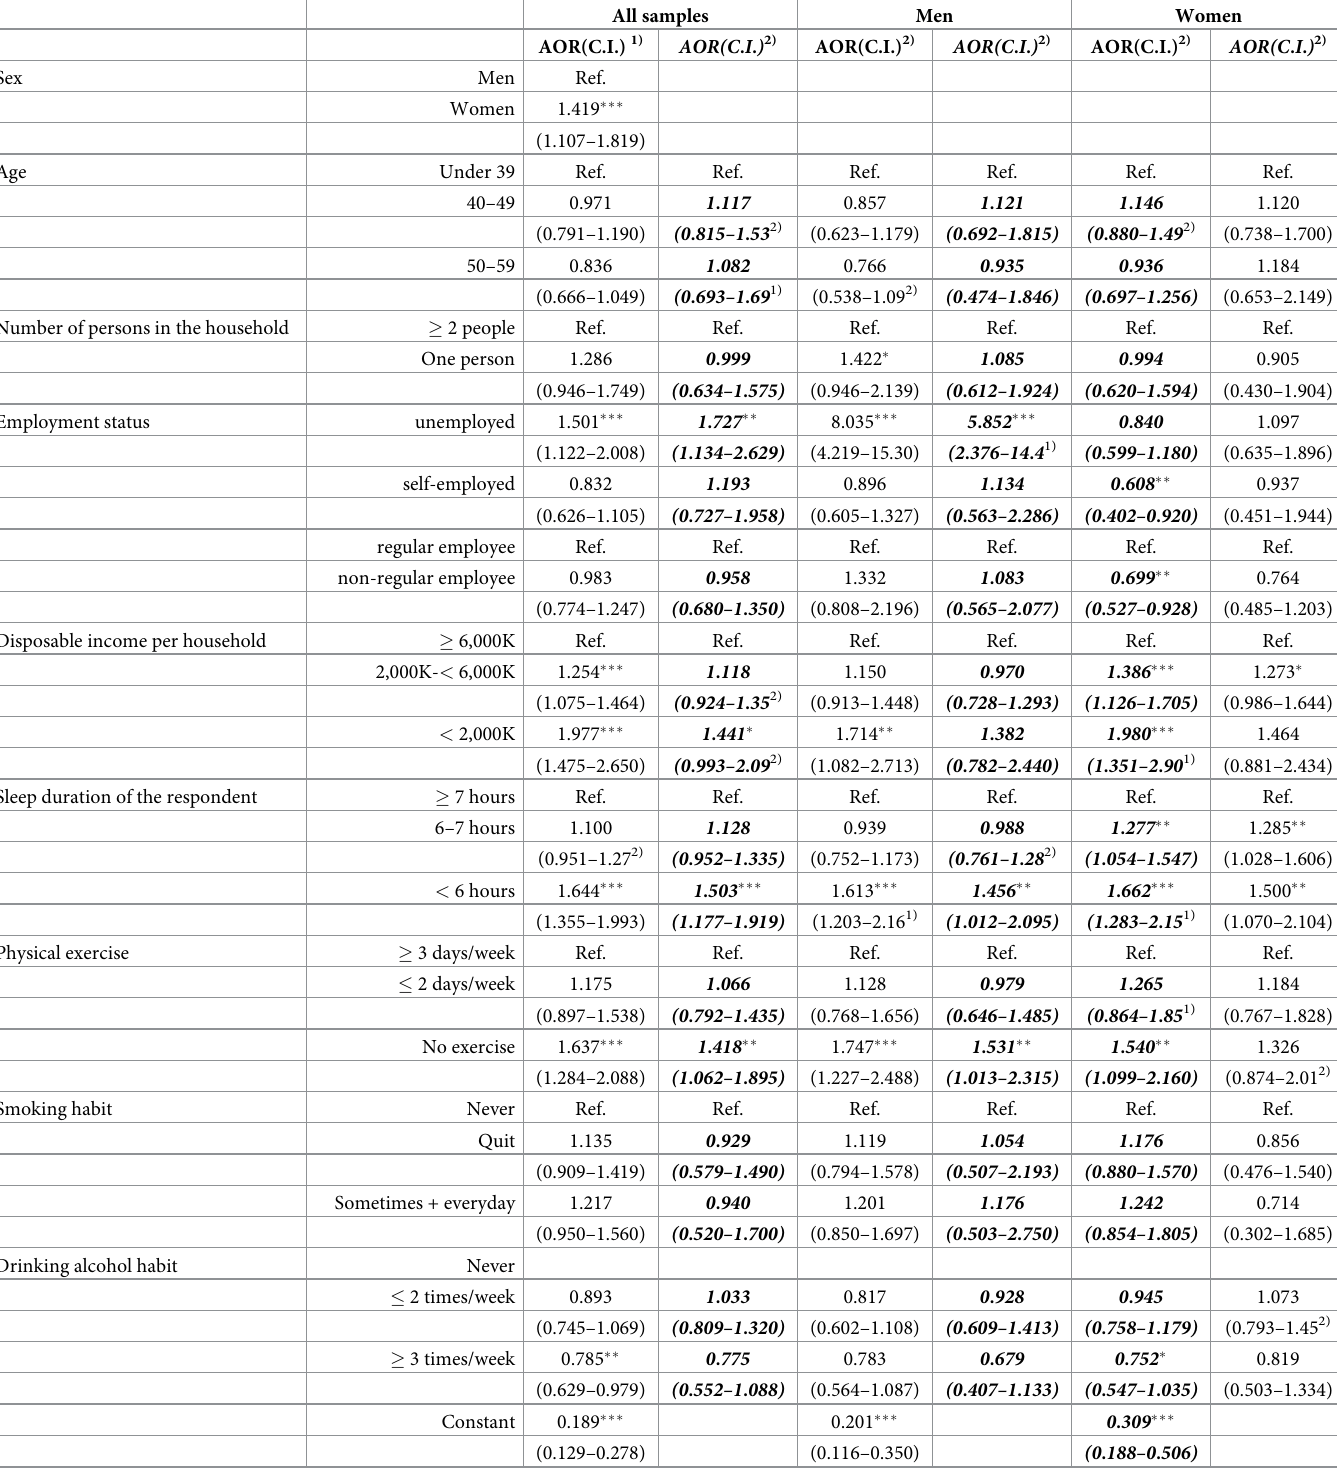
Table 3. Estimated associations between participants’ General Health Questionnaire 12-item scores and risk factors by gender based on the random-effects condi- tional logistic regression models, on the fixed-effects conditional logistic regression models and on the Hausman